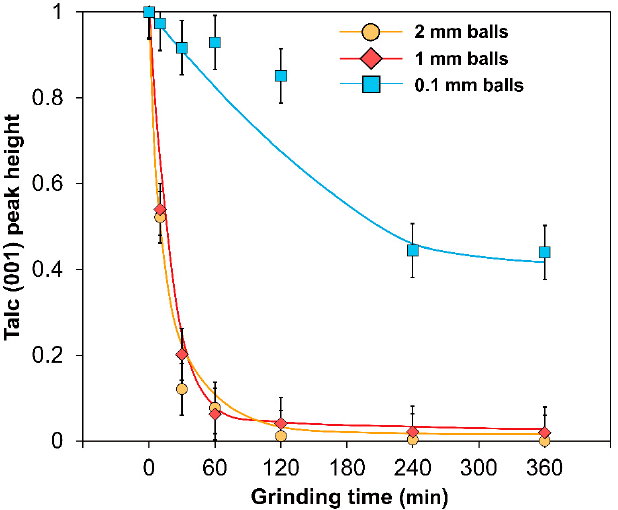
Figure 3. Changes in the relative intensities of (001) XRD peak of talc powder upon grinding with varying ball sizes for high ‐ energy ball milling. The relative peak intensities are normalized with the (001) XRD peak of as ‐ received talc.